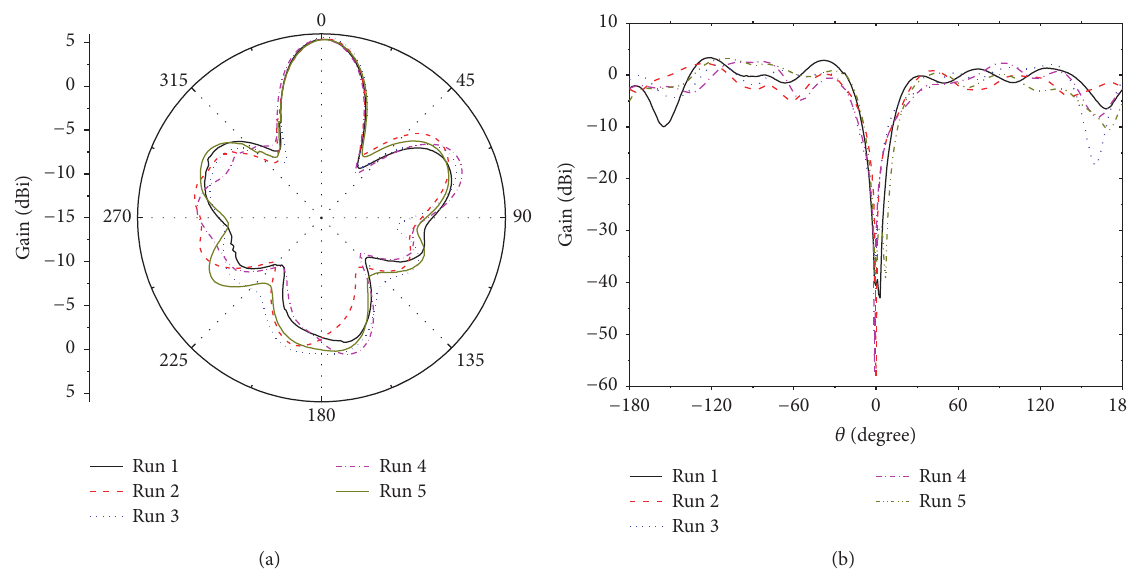
Figure 12: Radiation pattern for each 5GA optimized results. (a) High-gain modes. (b) Nulling modes.